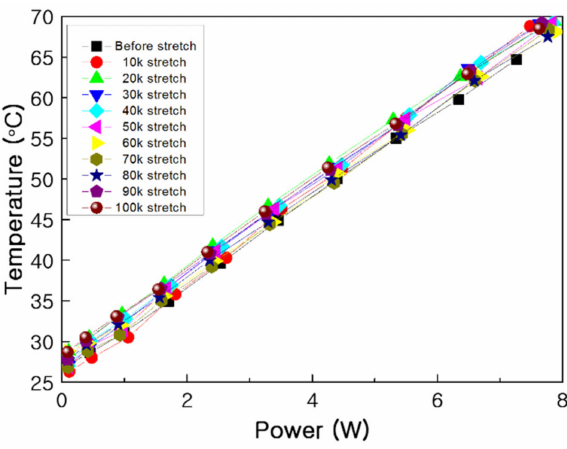
Figure 16. Power consumption and average heating temperature during stretching–contraction